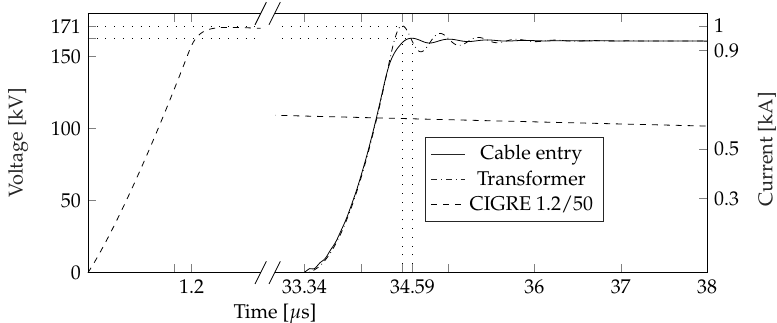
Figure 7. Ignoring grounding system: transmission system nodal voltages and CIGRE 1.2/50 µ s injected current stroke in far-end ( l l = 10 km).